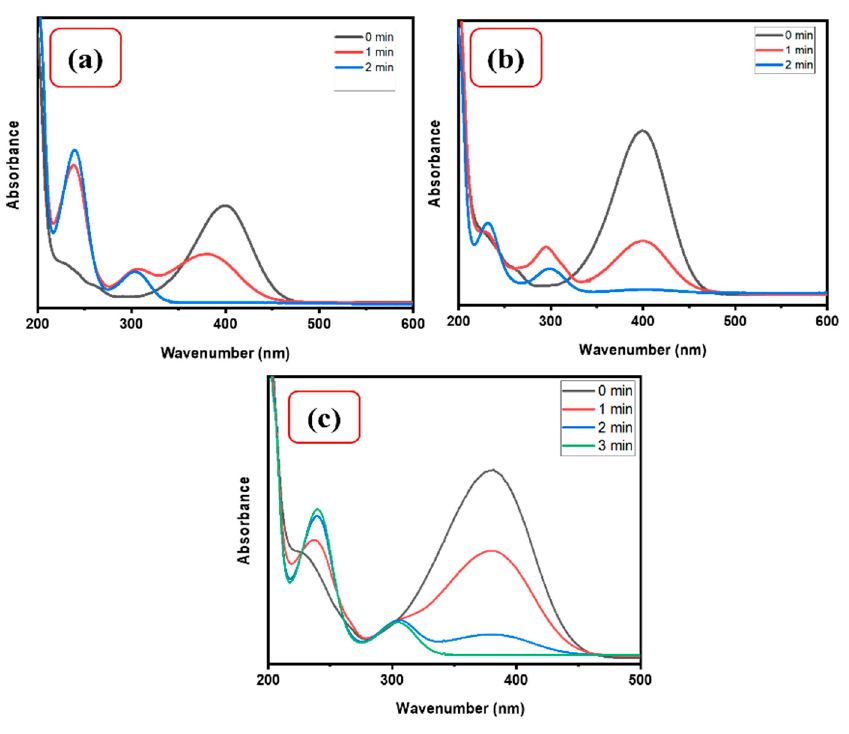
Figure 7. UV–Vis spectra for ( a ) 0.04, ( b ) 0.08, and ( c ) 0.13 mM 4-NP using 5 mg CMC/CuO-TiO 2 in the presence of NaBH 4 .